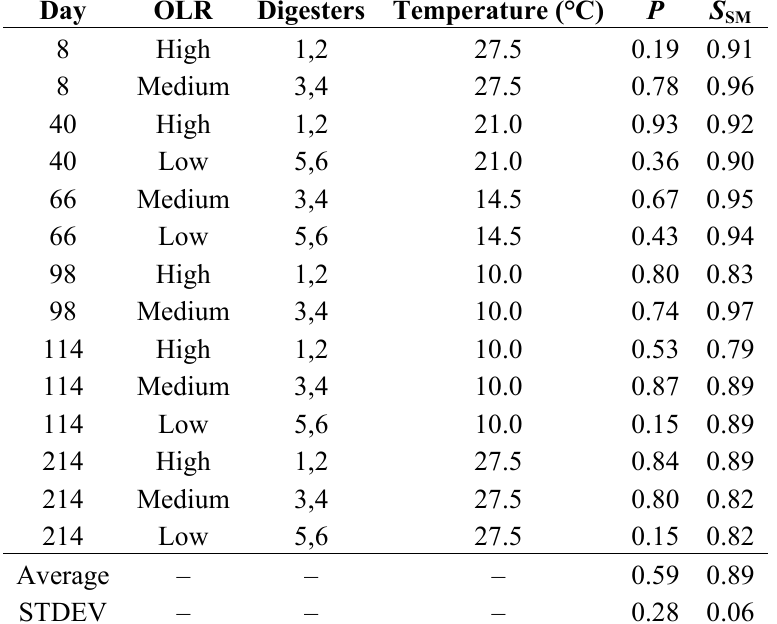
Table 1. Percent similarity ( P ) and the simple matching coefficient ( S communities in the replicate digester pairs. The missing replicate pairs are due to experimental